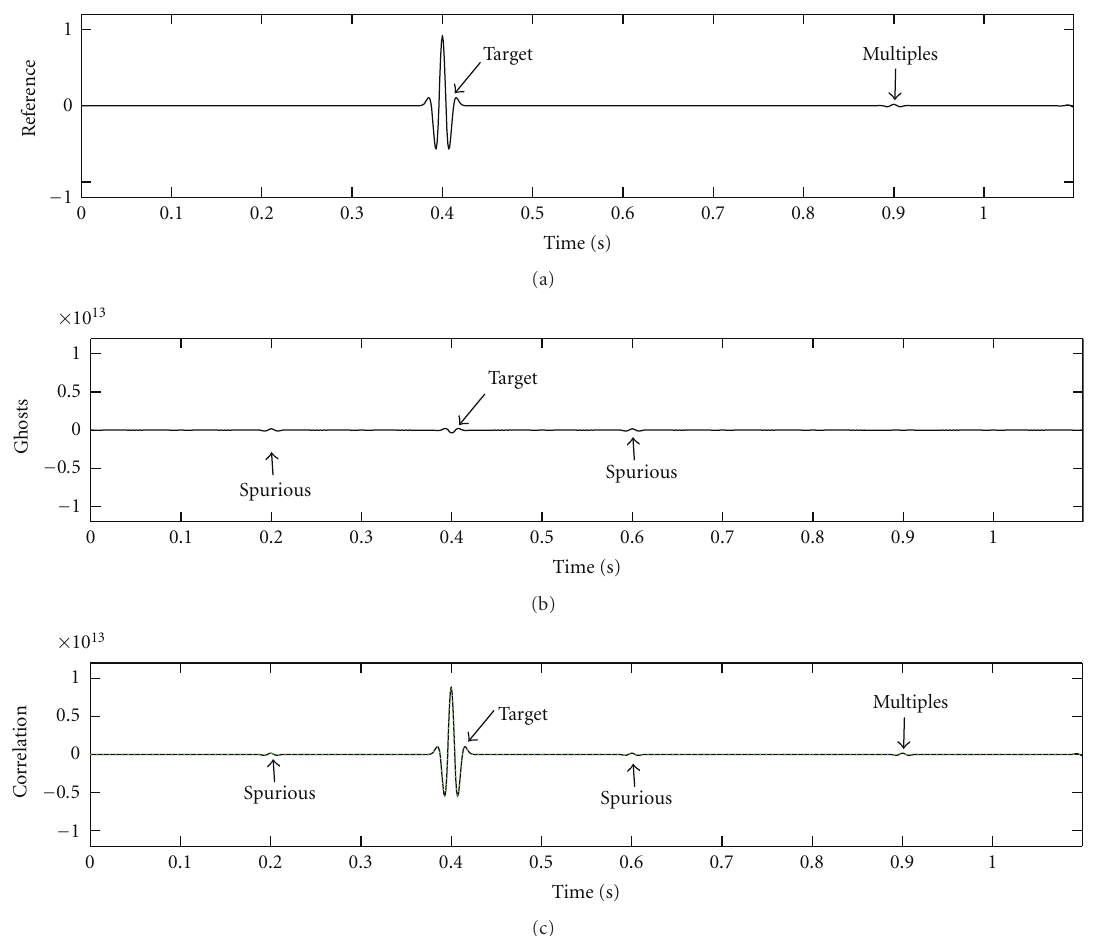
+ g O ; (c) correlation function C dcp (black) and the sum of reference response + ghosts (dashed dcp dcp